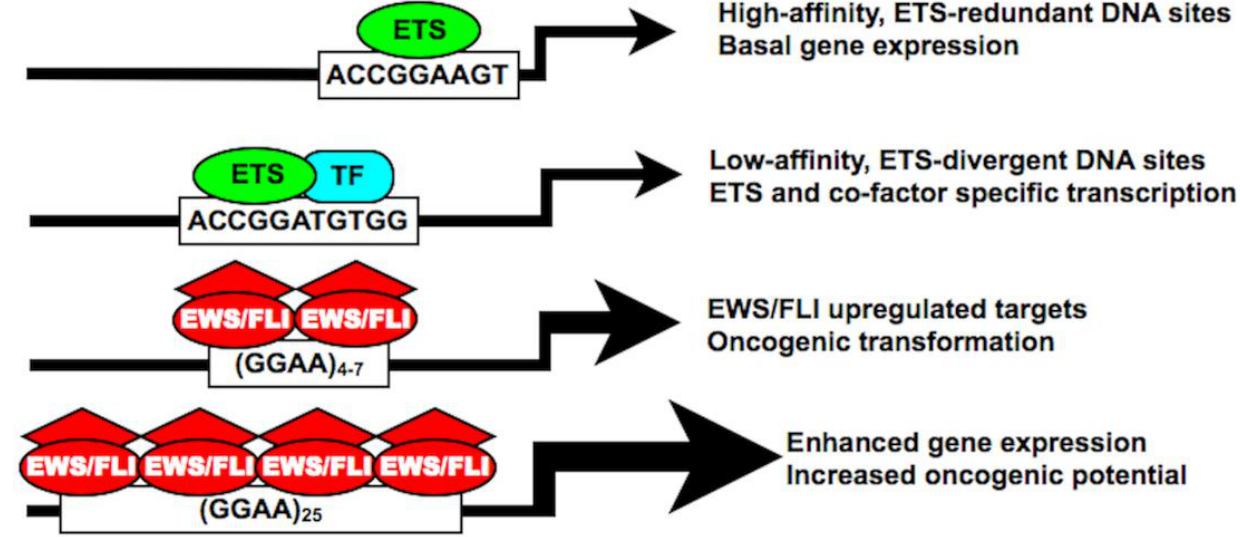
Figure 4. The EWS/FLI chimera possesses unique DNA binding affinities and biological properties distinct from native ETS family members. Both high- and low-affinity ETS DNA binding sites are characterized by a core ACCGGAA/T consensus sequence facilitating both ETS-redundant and ETS-divergent transcriptional regulation. In Ewing sarcoma, EWS/FLI also binds the traditional ETS-consensus sequence, but shows increased preference for a GGAA-containing microsatellite. In certain upregulated targets, this GGAA microsatellite response element is required for DNA binding and gene activation, which proportionately increases with an increasing number of GGAA motifs. (cid:179)(cid:55)(cid:41)(cid:180)(cid:3)(cid:32)(cid:3)(cid:87)(cid:85)(cid:68)(cid:81)(cid:86)(cid:70)(cid:85)(cid:76)(cid:83)(cid:87) ion